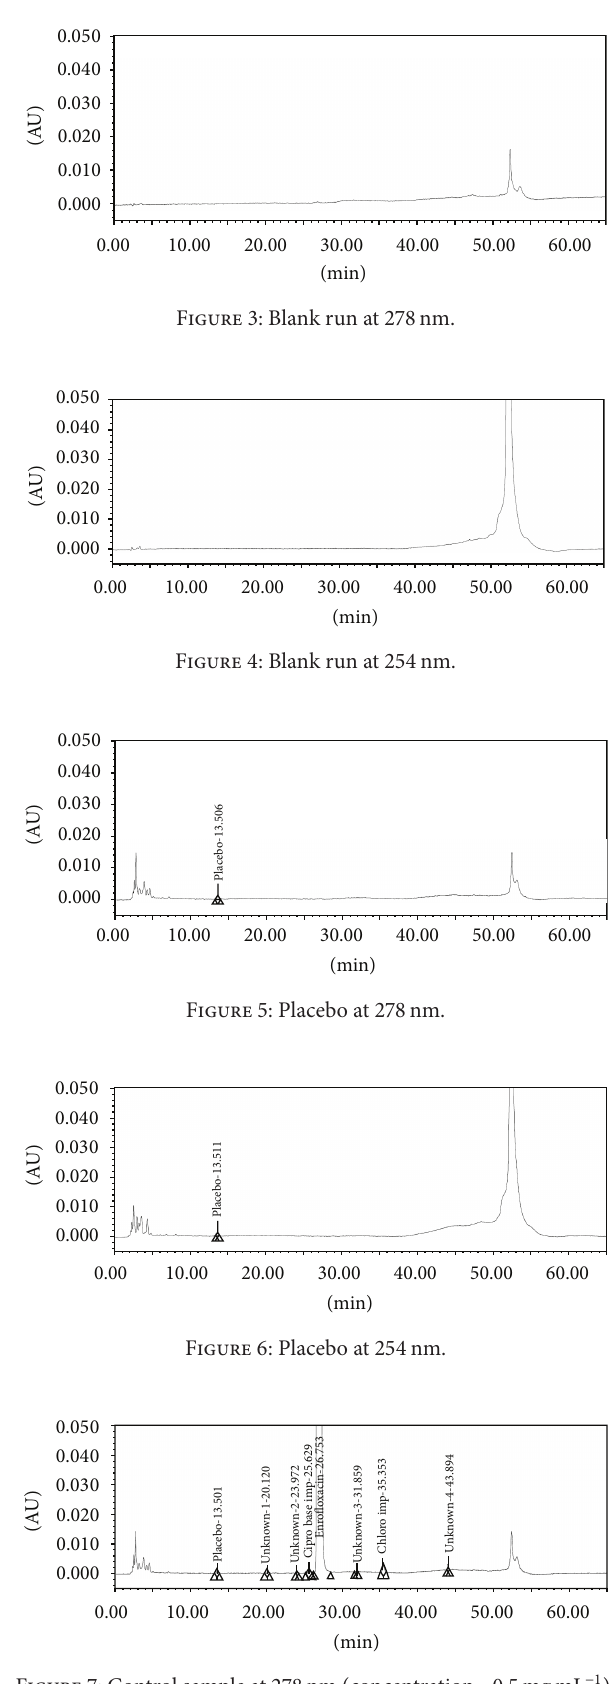
Figure 7: Control sample at 278 nm (concentration ∼ 0.5 mg mL −1